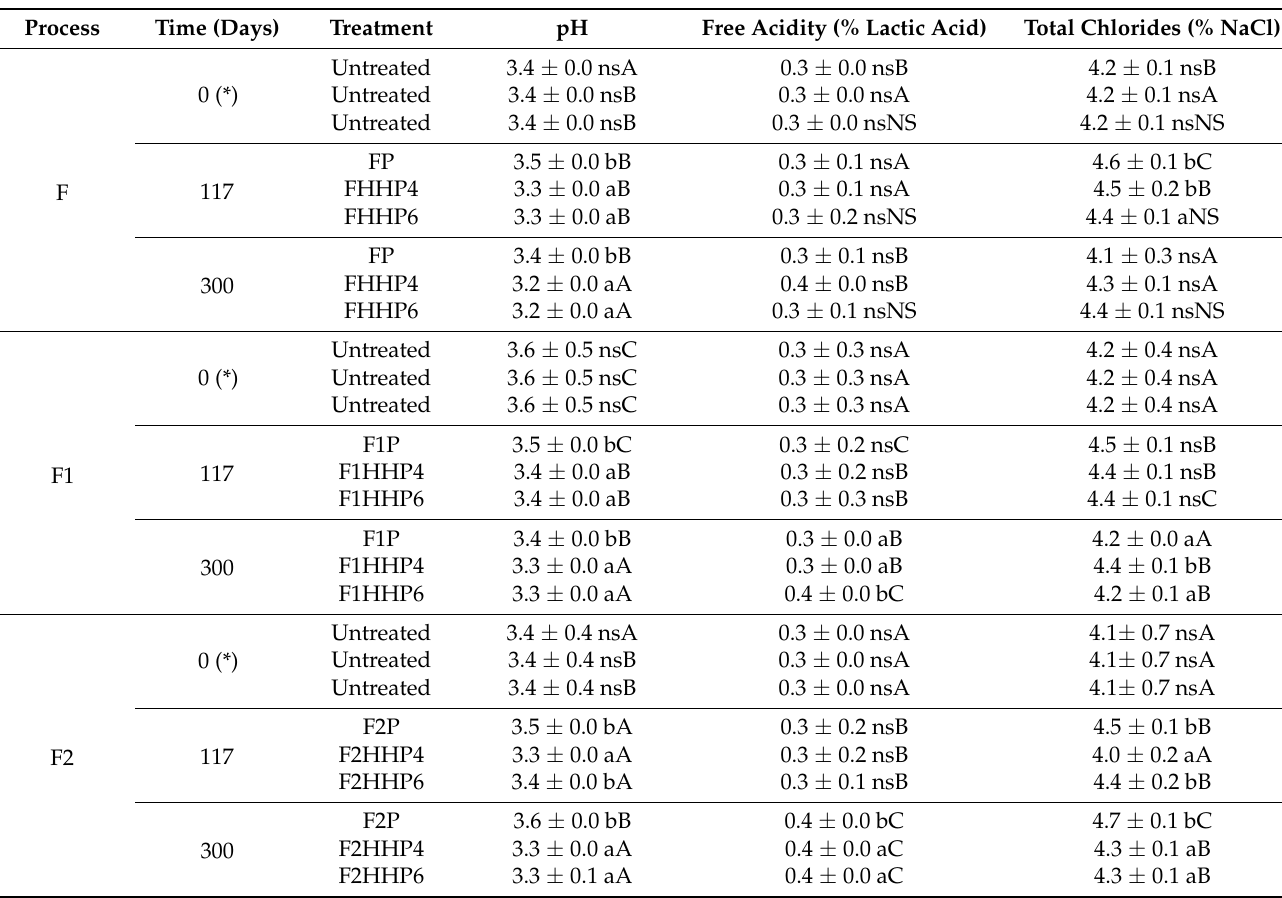
Table 1. Results for physical–chemical parameters (mean ± standard deviation). F: spontaneous fermentation of olives; F1: olives fermented with OLE + spontaneous fermentation; F2: olives fermented with OLE + S. cerevisiae; P: pasteurization treatment; HHP4: high hydrostatic